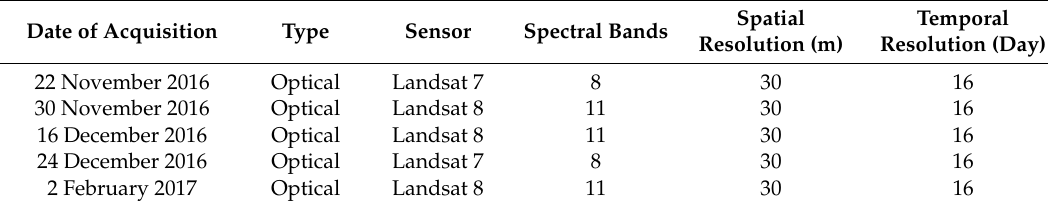
Table 2. Characteristics of Landsat images collected over the study